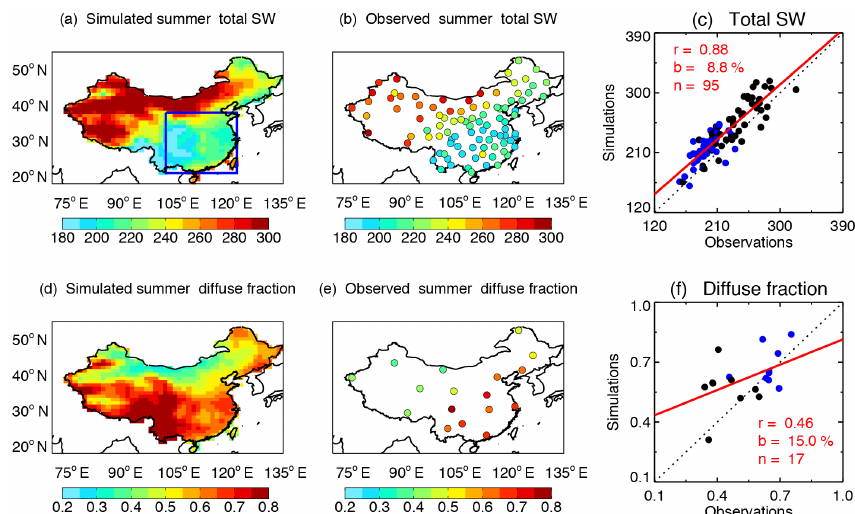
Figure 2. Evaluation of summertime radiation fluxes simulated with the CRM. Simulations are (a) surface total shortwave radiation (Wm − 2 ) and (d) diffuse radiation fraction from ALL010 with 1 ◦ × 1 ◦ resolution. Observations ( b and e ) are the average during 2008–2012 from 106 sites operated by the Climate Data Center, Chinese Meteorological Administration. The correlation coefficients ( r ), relative biases ( b ), and number of sites ( n ) are shown in the scatter plots ( c and f ). The blue points in the scatter plots represent sites located within the box regions in eastern China as shown in (a) . The dashed line represents the 1 : 1 ratio. The red line is the linear regression between simulations and